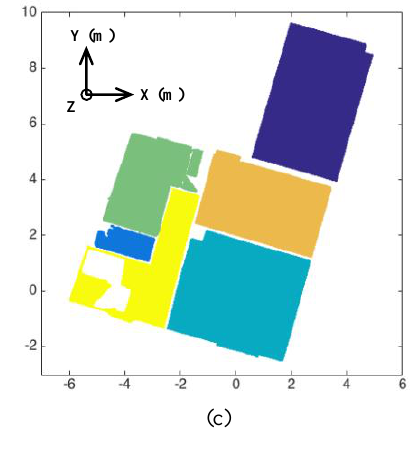
Figure 4. Floor segmentation results: (a) individual house; (b) 3 floors of the INSA building